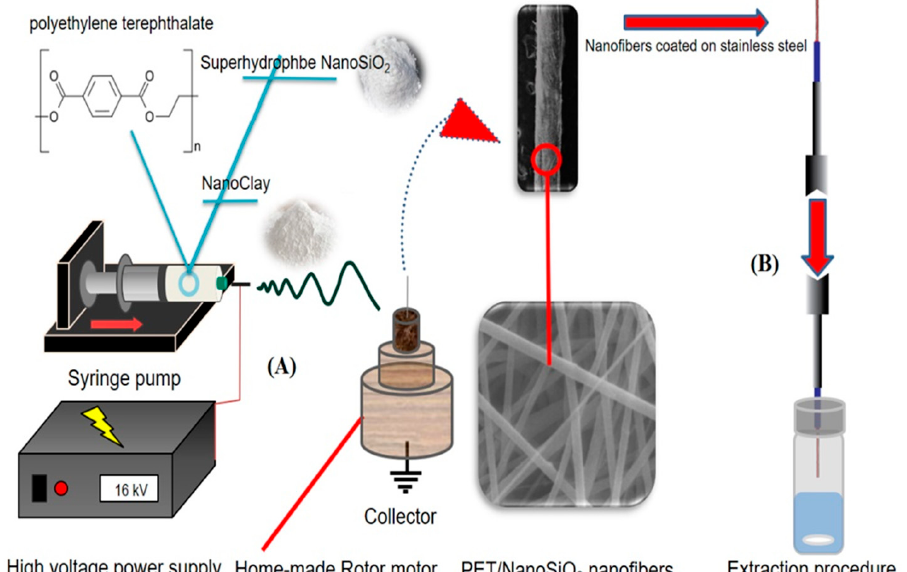
Figure 1. ( A ) The setup design for electrospinning process, and ( B ) headspace–SPME procedure.